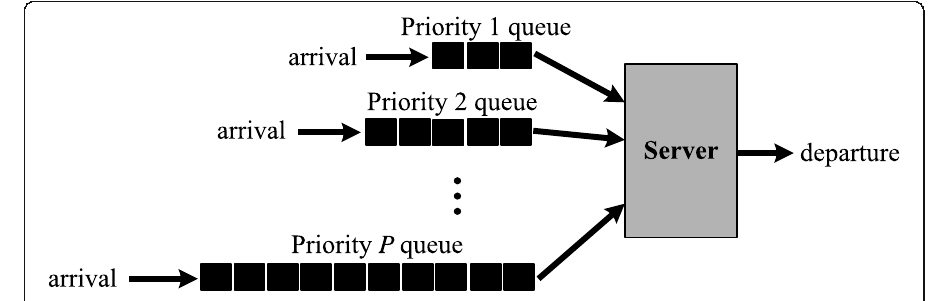
Fig. 4 Multi-queue single-server queueing system in each node